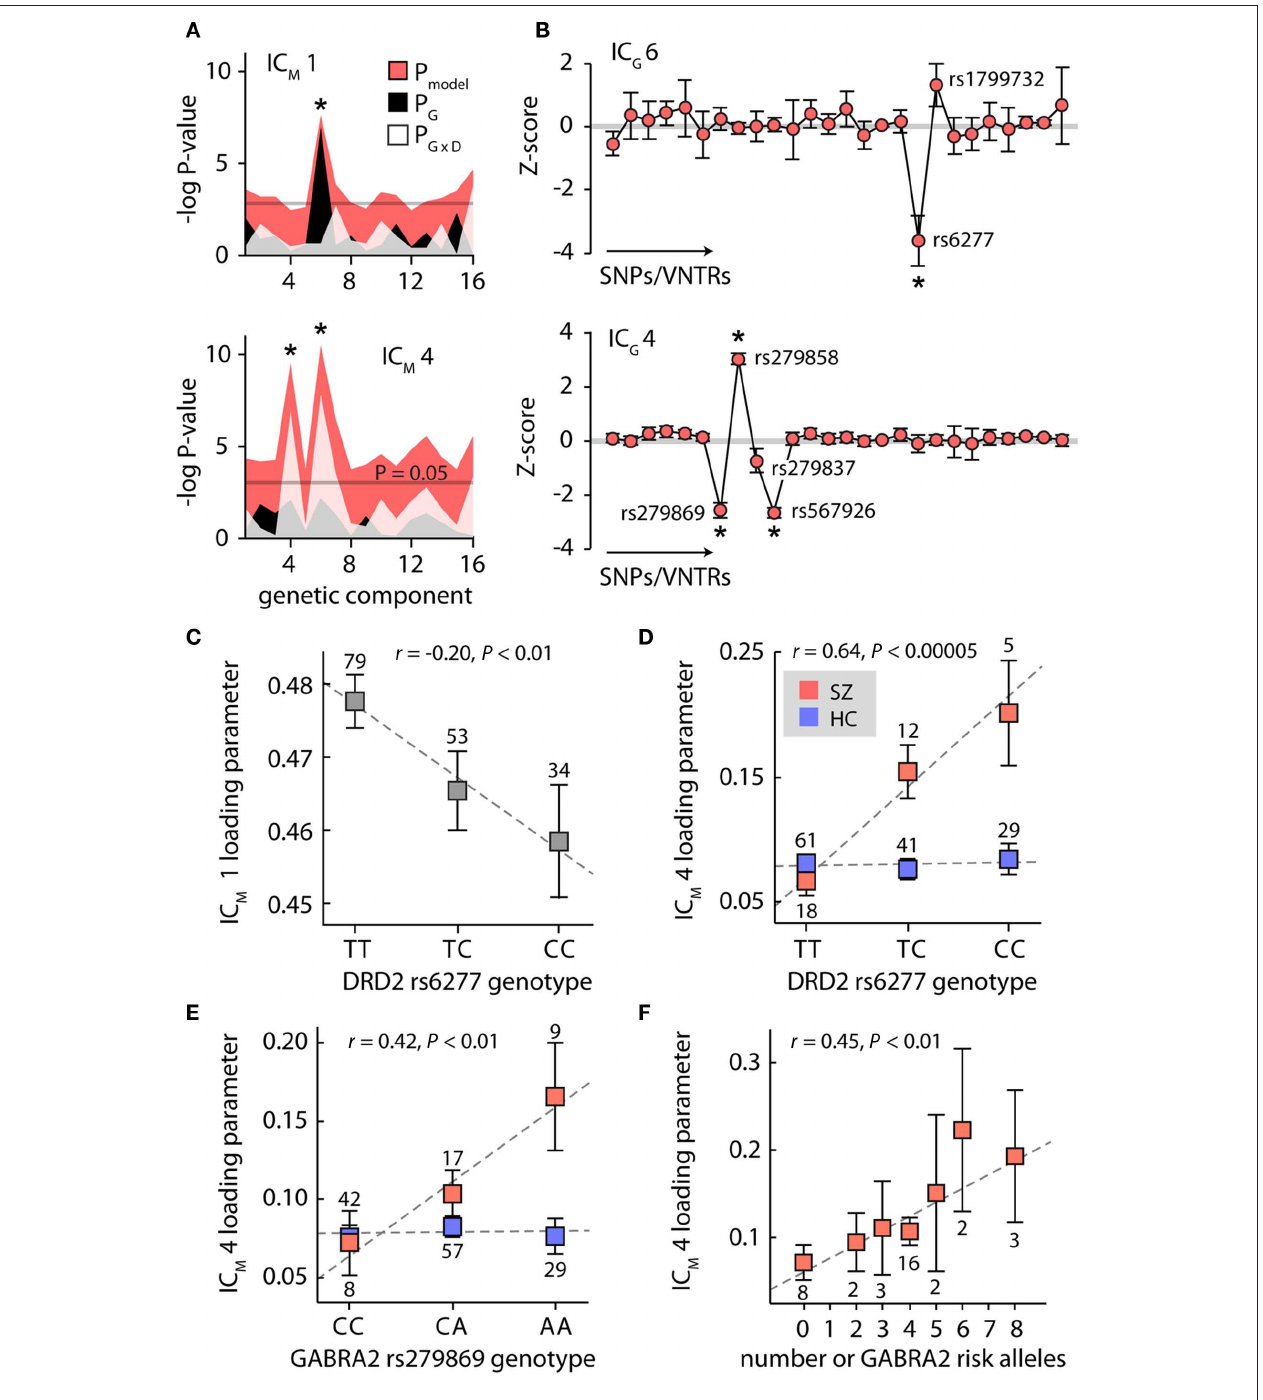
bootstrap resamplings. Asterisks denote polymorphisms contributing weights significantly different from zero ( P < 0.05, corrected for 26 tests). (C–F) Plots of modulation component loading parameters as a function of genotype. In (D) and (E) , data is stratified by SZ (red) and HC (blue) to highlight group × diagnosis interactions. In (F) , the number of risk alleles is determined from the genotypes of rs279869, rs279858, rs279837, and rs567926; for clarity, only the SZ group data is shown. Dashed line shows the least-squares linear fit to the data. The number of individuals with each genotype is indicated adjacent to the